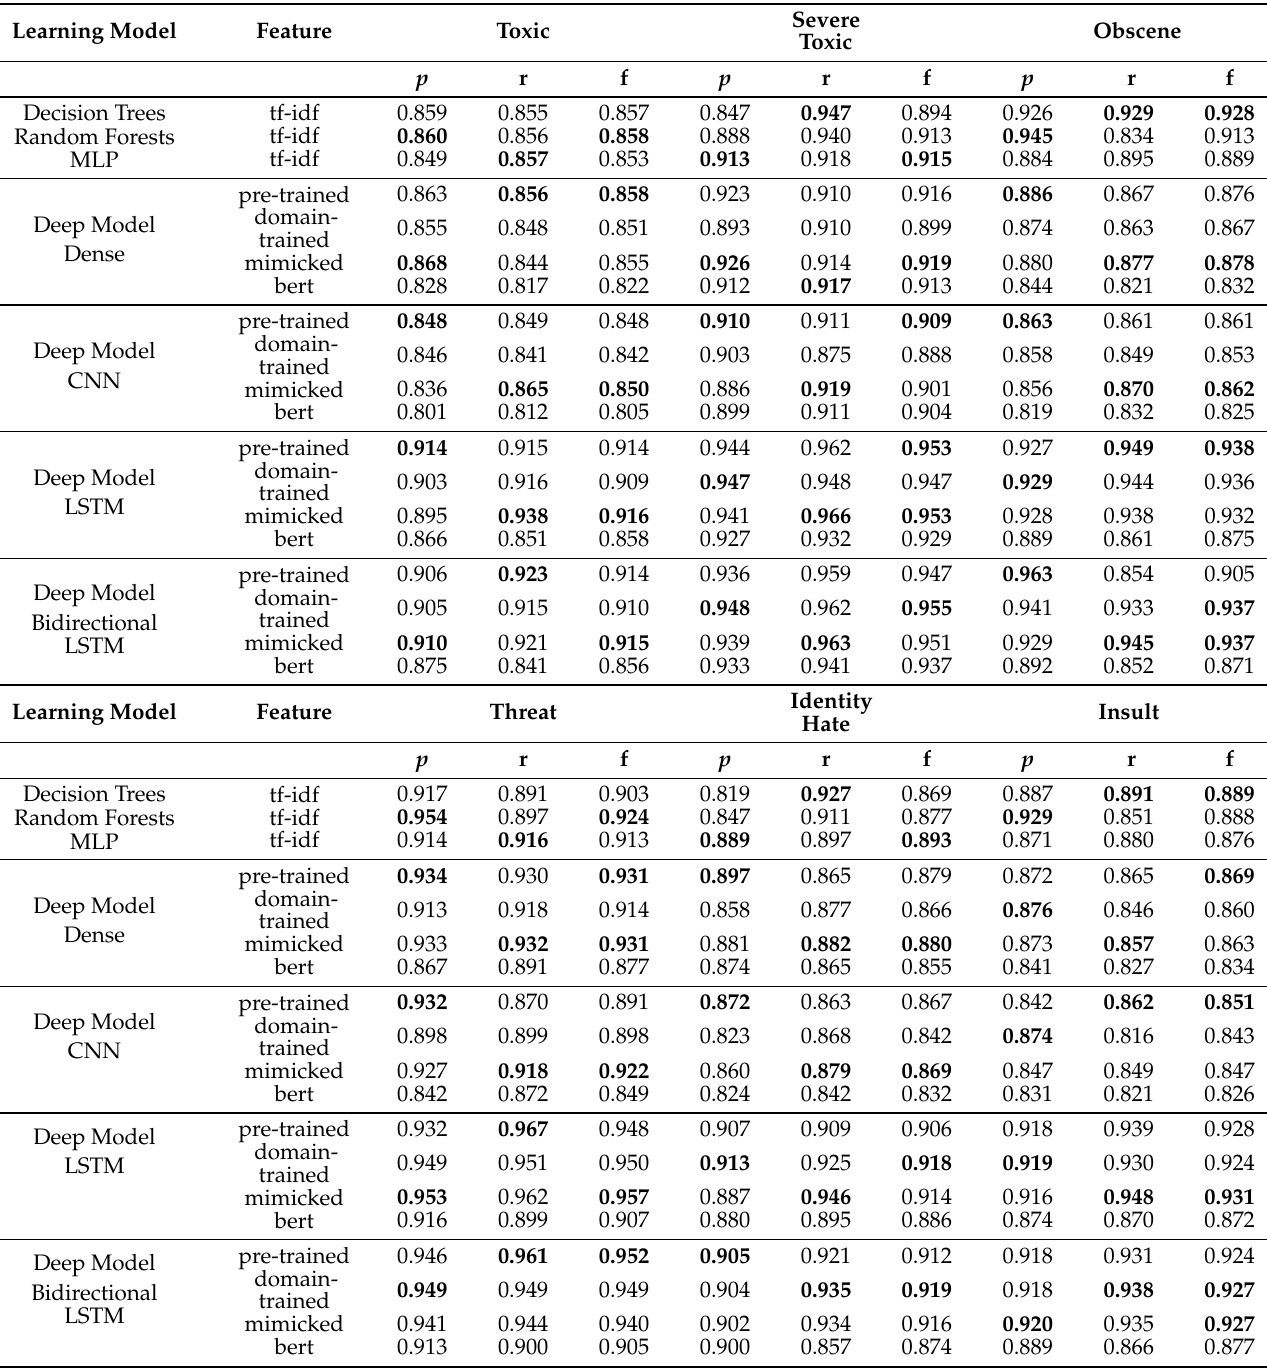
Table 3. Precision (p), recall (r), and f-measure (f) related to the binary classification for each toxicity class using the balanced